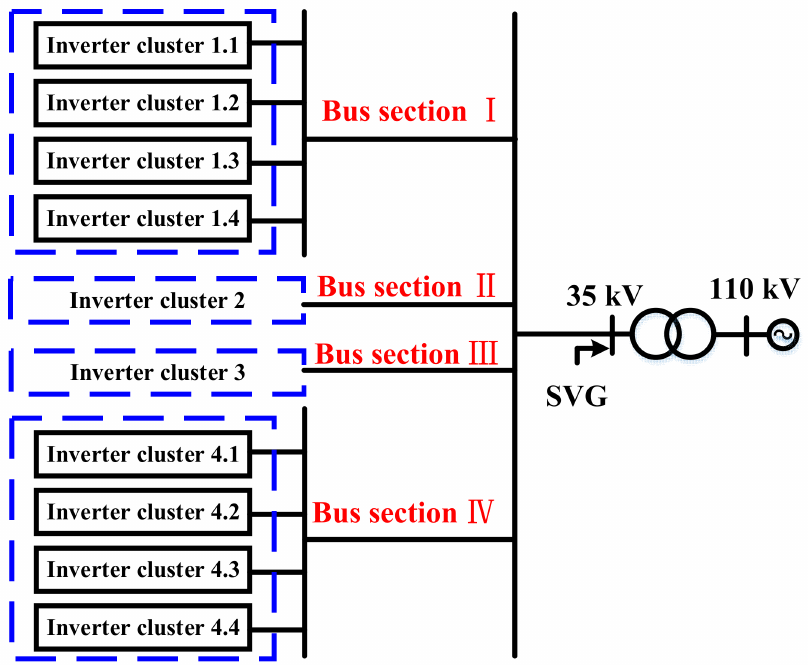
Figure 1. Structural diagram of the investigated 200 MW photovoltaic